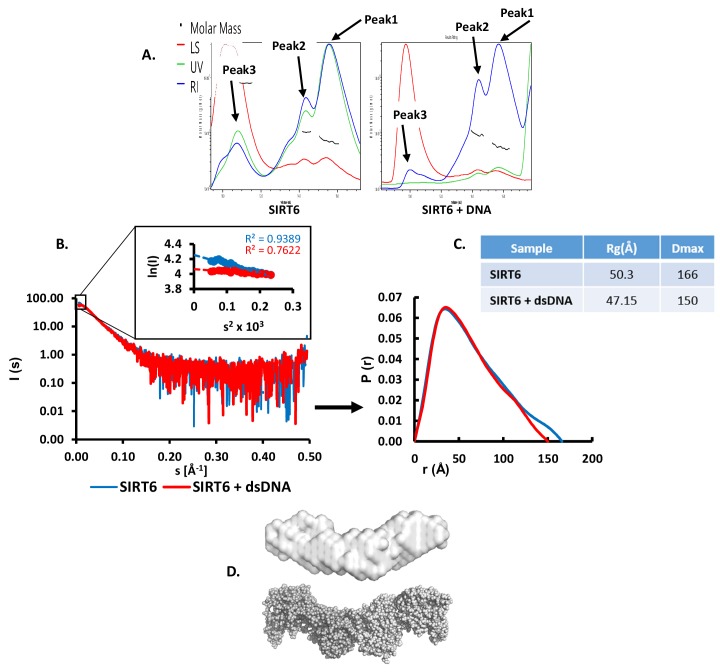
SIRT6 binds DNA with no intermediates.(A) SEC-MALS analysis of SIRT6 or of SIRT6 with a dsDNA 10-bp oligo with 3-bp overhanging ends on both sides. For SIRT6: Peak1 protein mass (calculated by UV) = 66.7 ± 3.3 kDa, protein mass (calculated by RI) = 70.7 ± 3.5 kDa; Peak2 protein mass (calculated by UV) = 114.3 ± 5.7 kDa, protein mass (calculated by RI) = 103.8 ± 4.9 kDa; Peak3 protein mass (calculated by UV) = 609.7 ± 14.6 kDa, protein mass (calculated by RI) = 833.6 ± 16.4 kDa. For SIRT6 +DNA: Peak1 protein mass (calculated by UV) = 52.5 ± 3.1 kDa, protein mass (calculated by RI) = 55.7 ± 3.2 kDa; Peak2 protein mass (calculated by UV) = 99.4 ± 3.8 kDa, protein mass (calculated by RI) = 94.6 ± 3.5 kDa; Peak3 protein mass (calculated by UV) = extremely high, protein mass (calculated by RI) = 9224 ± 258 kDa. (B) X-ray scattering profile (right) and the distance distribution function (left) of SIRT6 (blue) and SIRT6 bound to dsDNA (red). (C) Overall parameters for small angle X-ray scattering of SIRT6 alone and of SIRT6 bound to dsDNA determined from the distance distribution function P(r). Rg is the radius of gyration, and Dmax is the maximum dimension of the particle. (D) SAXS structure of SIRT6 (grey surface). Ab initio models were reconstructed from SAXS data using the computer program DAMMIN (Svergun, 1999) and were averaged by the computer program DAMAVER (Volkov and Svergun, 2003). The crystal structure of SIRT6 tetramer (grey spheres) was extracted from the crystal structure of SIRT6 (pdb id: 3PKI) and compared with the obtained SAXS model in PyMOL (http://www.pymol.org).